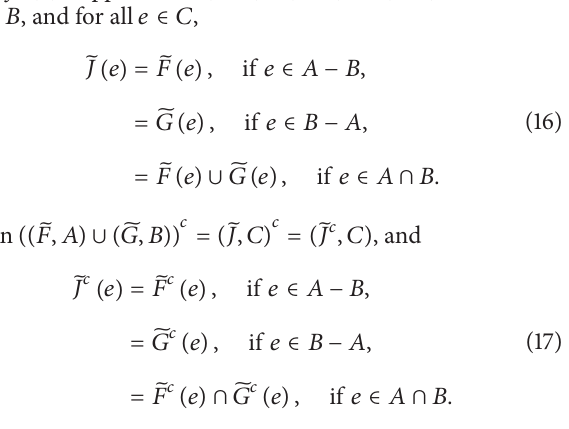
Table7:TheIntersectionofhesitantfuzzysoftsets